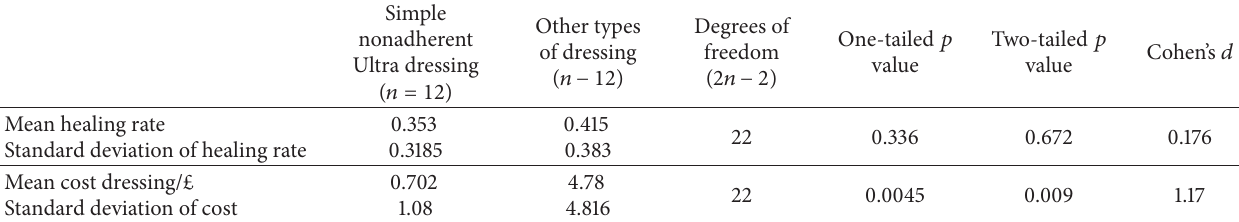
Table 3: Cost is significantly different between simple dressings and modern dressings. However the healing rate between the two is not significantly different.